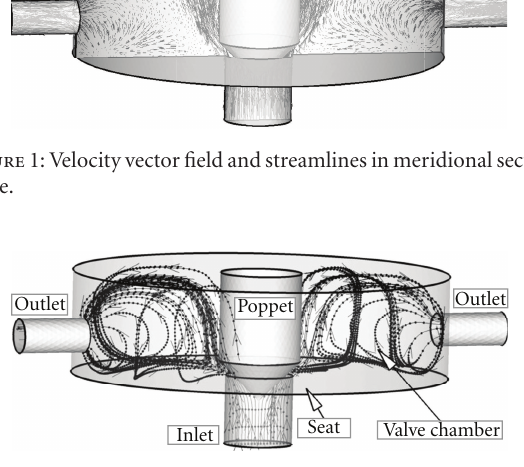
Figure 2: Flow field representation using selected streamlines inside the poppet